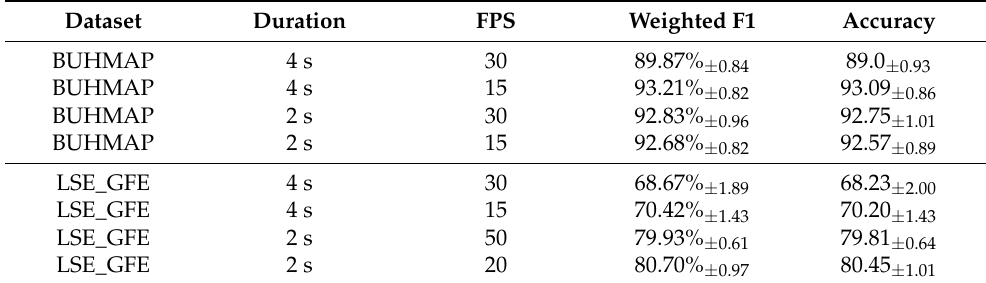
Table 10. Ablation study on duration and FPS. Empty-graph, horizontal flipping and one single scale in both spatial and temporal dimensions.